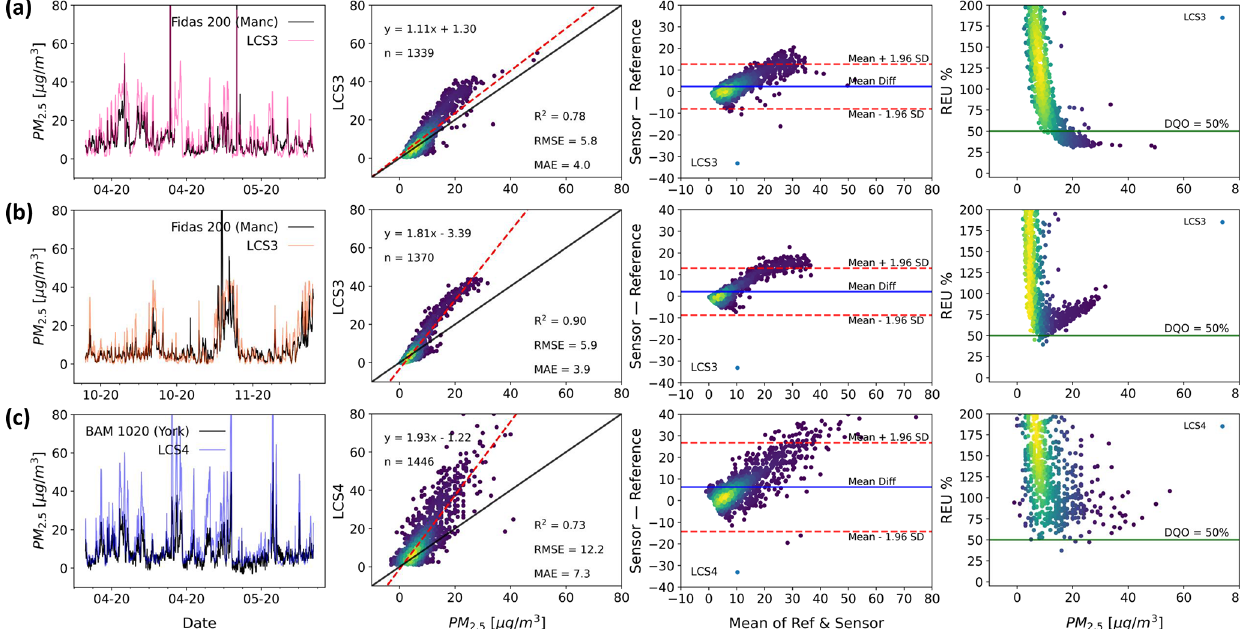
Figure 6. Two LCS systems (LCS3 and LCS4, same brand) measuring PM 2 . 5 (time resolution 1h). While LCS3 is shown for the same location (Manchester) but unfolded in two different seasons ( a : April to May 2020; b : October to November 2020), LCS4 is at a different location ( c : York, April to May 2020). Time series (first column), regression (second column), Bland–Altman (third column) and REU (fourth = 50%) plots are used to characterise the device’s error structure. All but the time series plots have been coloured by column; DQO PM 2 . 5 data density. (Darker colours denote lower density and lighter colours denote higher